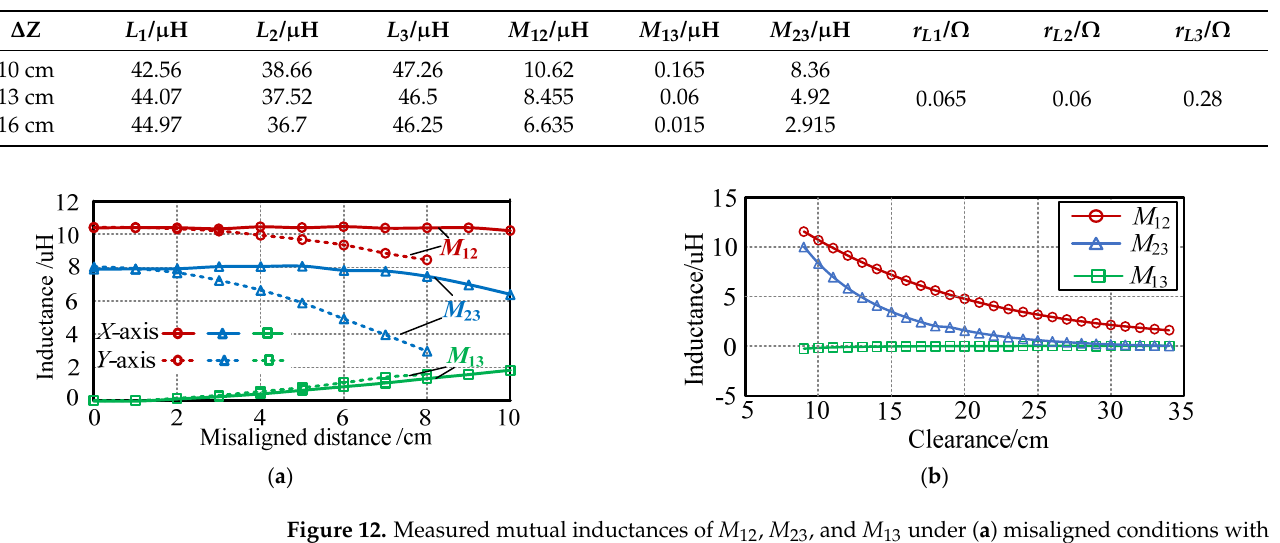
(c) Figure 13. Experimental waveforms of v 3 , v 3_s , and i 2 under the condition of ( a ) ∆ X = ∆ Y = 0 cm; ( b ) ∆ X = 0 cm and ∆ Y = 6 cm; ( c ) ∆ X = 4 cm and ∆ Y = 0 cm. ( ∆ Z = 10cm). 5.3. Parameter Estimation Results 5.3.1. Offline Parameter Estimation Offline parameter estimation is conducted under weak excitation with V in = 30 V. Re- lay S 1 in Figure 4 is switched to the test resistor Ro , and Ro is fixed at 8 Ω during the estimation process. Following the procedure provided in Figure 5, M 12 , L 1 , L 2 , and r 1 are obtained, as illustrated in Table 4 and Figure 14. Table 4. Estimated results of M 12 , L 1 , L 2 , and r 1 at different clearances. ∆ Z